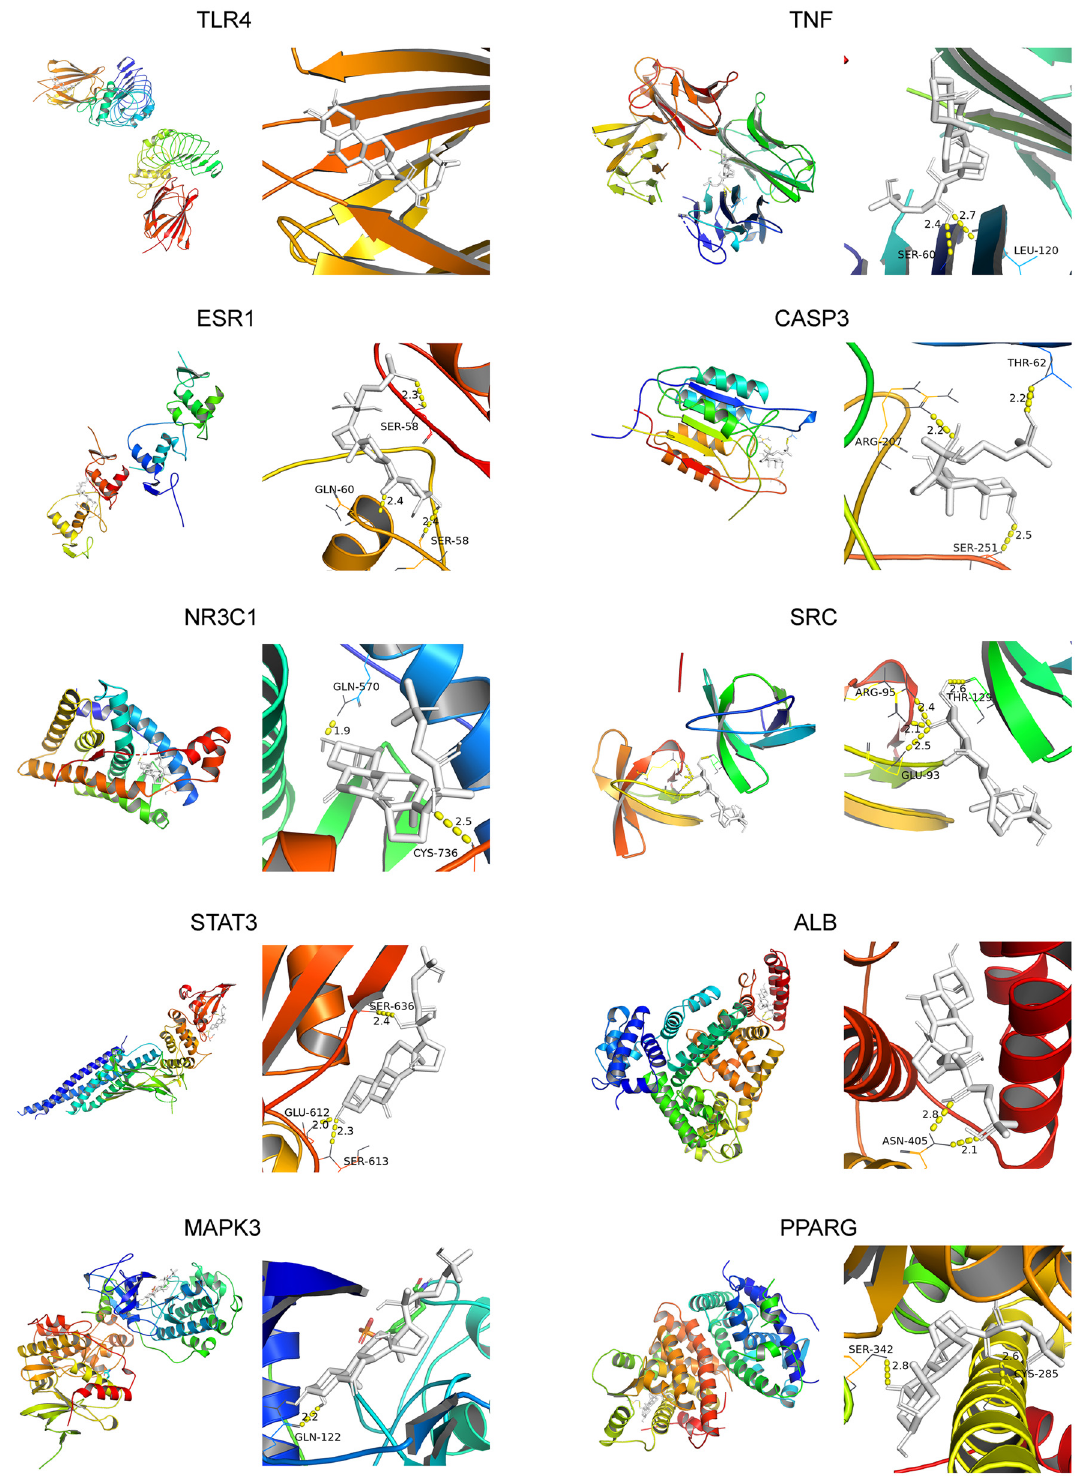
Figure 4: Molecular docking of β - ecdysone with top 10 hub osteoporosis - related